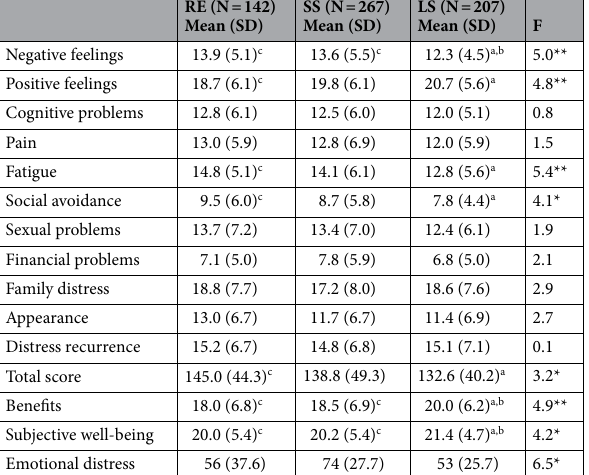
Subgroup with AHT (N =